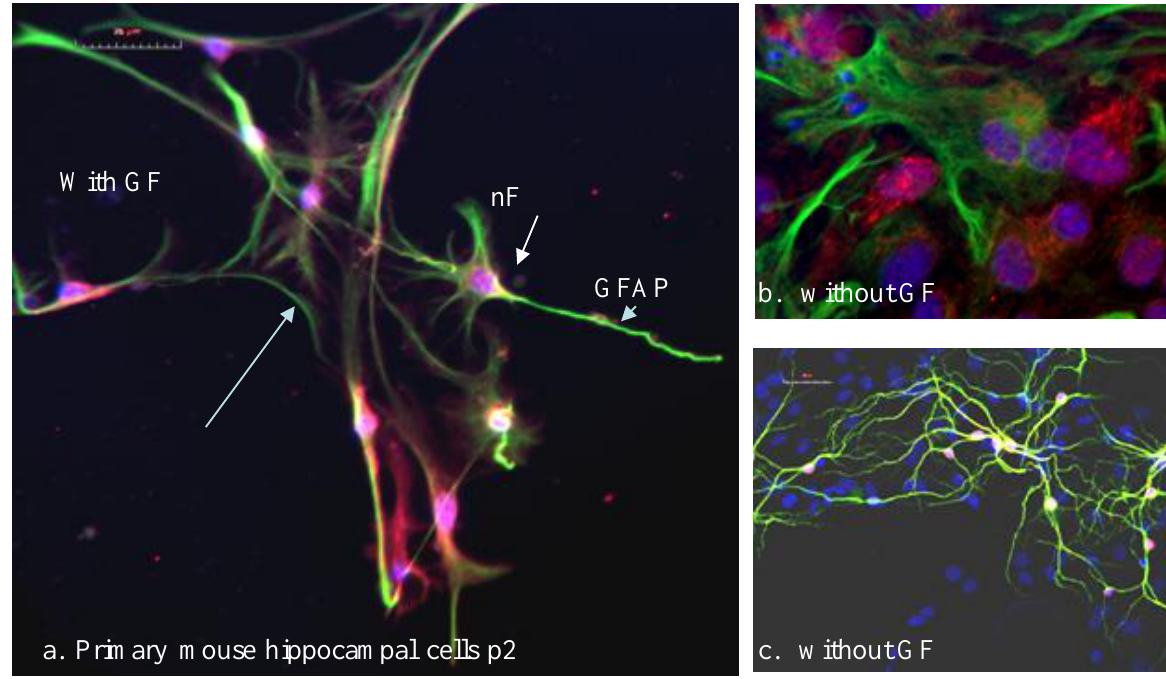
Figure 2. Primary mouse hippocampal cells cultured in vitro on coverslips with (a) and without growth factors (GF) (b, c), then fixed and stained for neuronal cells with markers neurofilament (nF) red and glial cells with (GFAP) green (a, b), and neural cells MAP2 (c) with DAPI stained nuclei